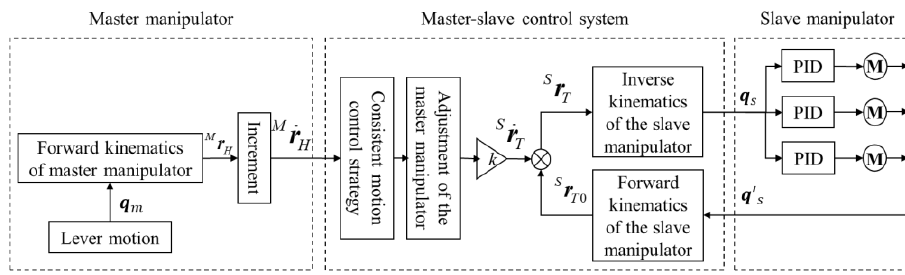
Figure 9. Master–slave coordinate system definition. Figure 9. Master – slave coordinate system definition. Figure 9. Master – slave coordinate system definition.